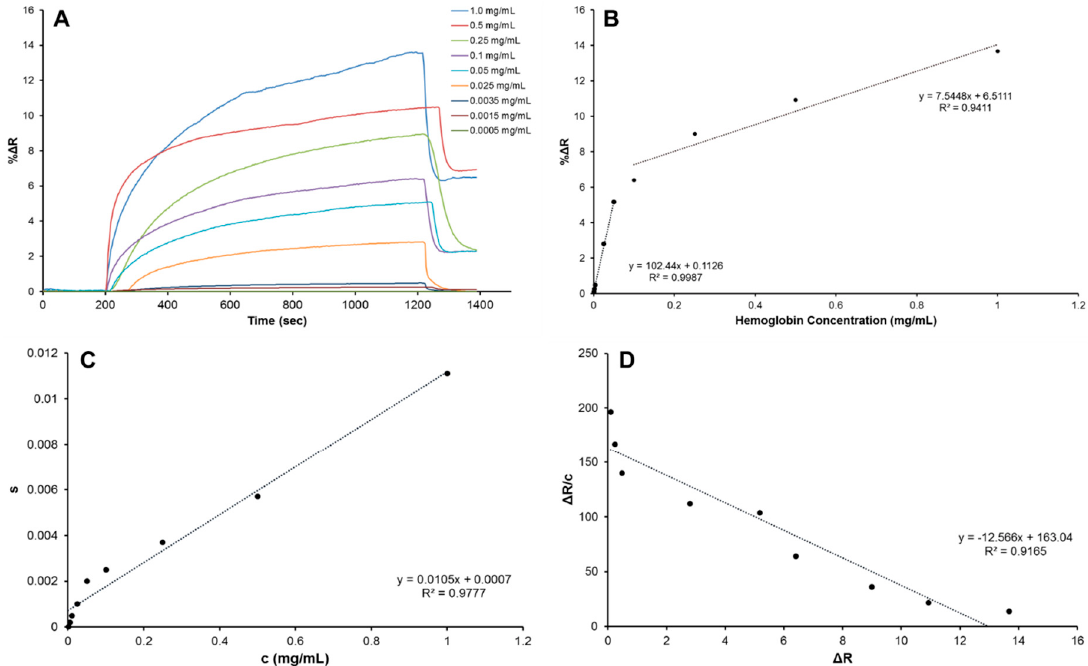
Figure 2. The combination of real-time responses ( A ), the calibration curve of molecularly imprinted nanofilm on-chip response to hemoglobin sample solutions ( B ), association kinetics analysis ( C ) and equilibrium analysis ( D ).